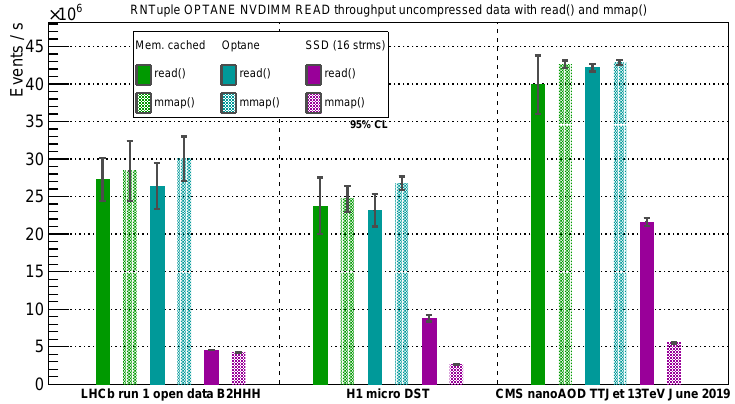
Figure 8. Read performance using Optane DC NV-RAM in “App Direct” mode on machine 1. The NV-RAM block device is formatted with ext4 with DAX optimization. Uncompressed input data is used in order to allow for comparsion between POSIX read() and mmap() . Note that the SSD read() results are identical to the 16 streams result in Figure